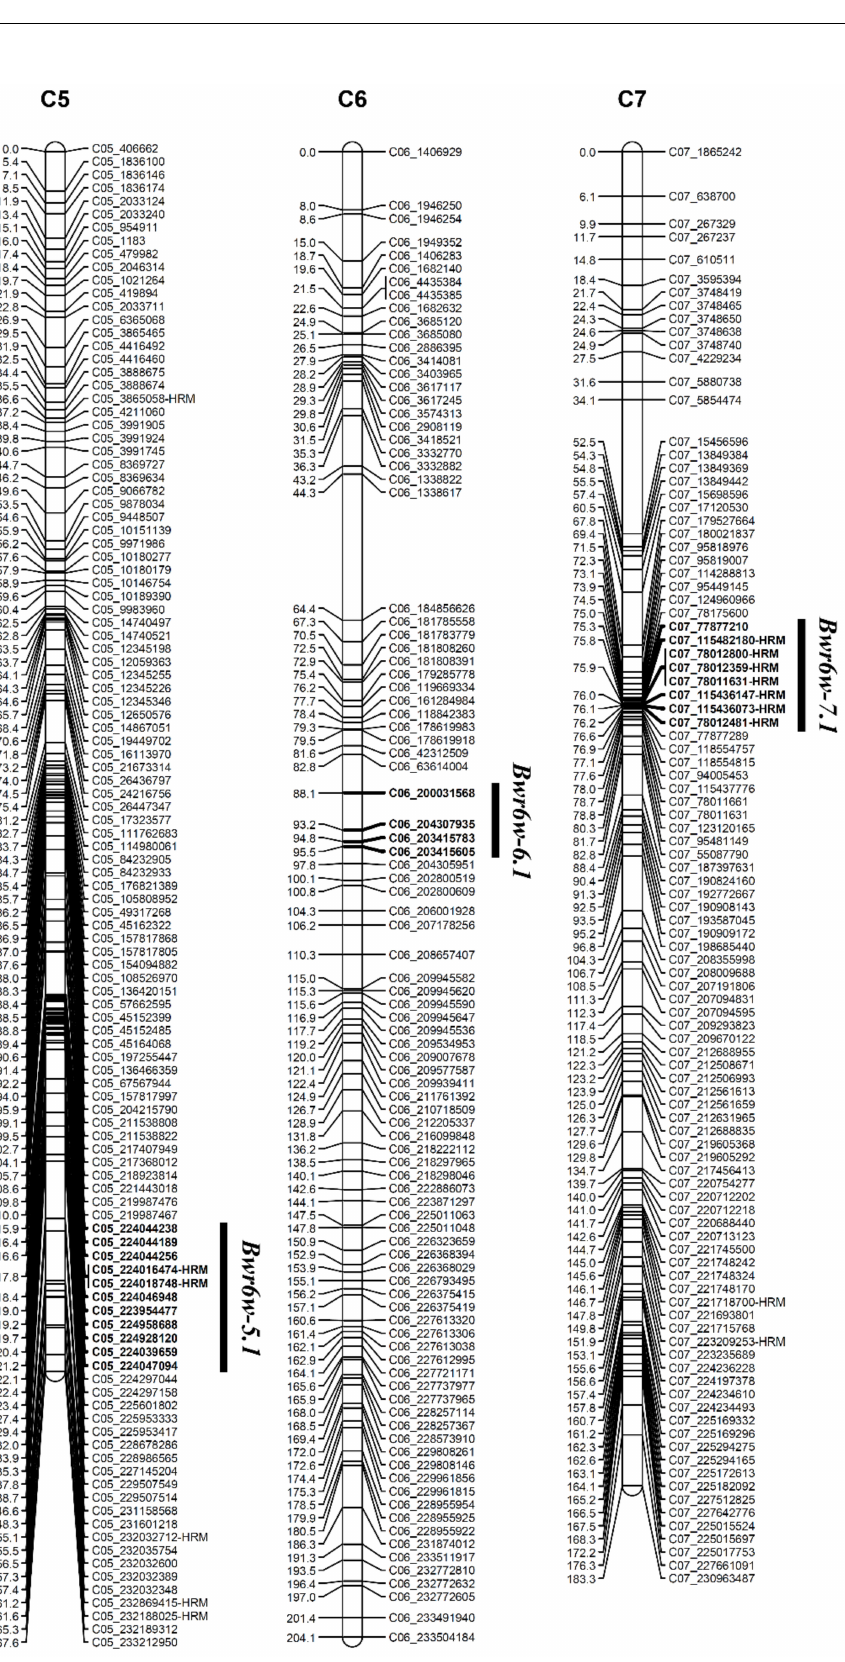
Figure 3. Map position of QTLs for the resistance to bacterial wilt caused by a highly pathogenic ‘HWA’ isolate of Ralstonia solanacearum in an F 2 population of the strongly resistant hybrid pepper cultivar ‘Konesian Hot’. Bar left number, genetic position (cM); bar right name, name of SNP marker; bold, markers located within each QTL